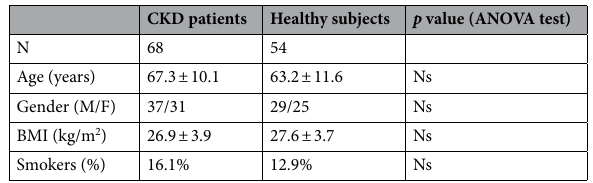
Table 6. Epidemiological features and homogeneity of the two study